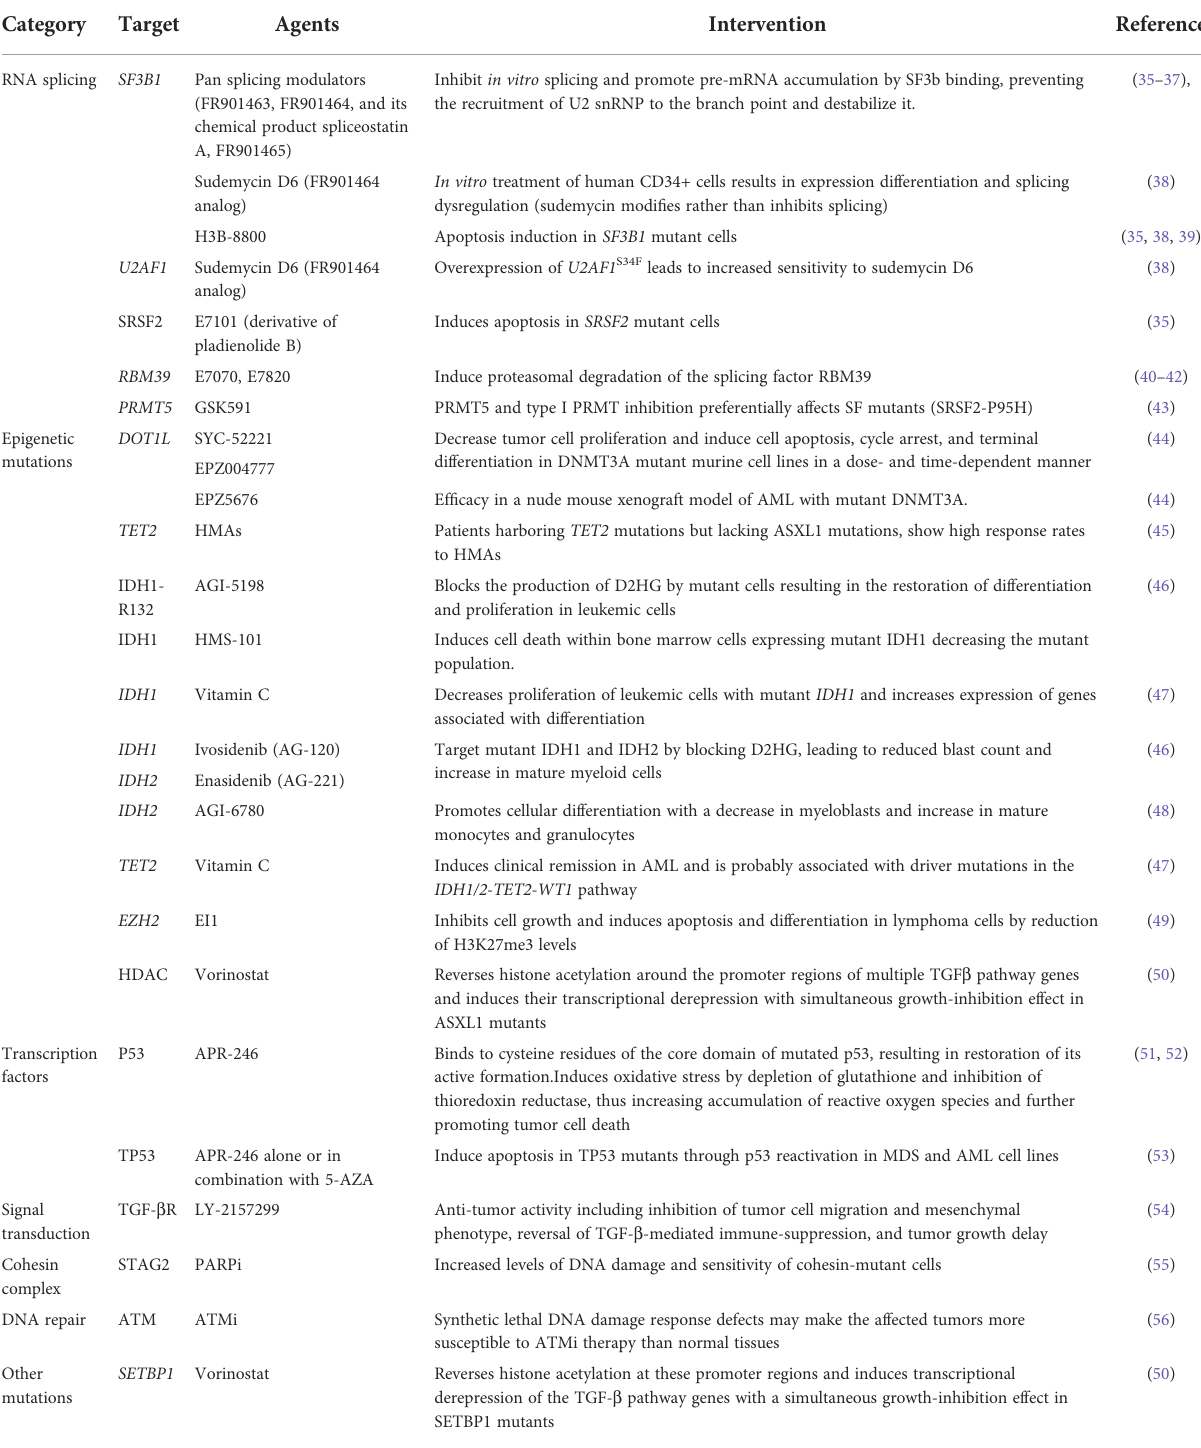
TABLE 2 Preclinical data on agents targeting mutations commonly found in patients with myelodysplastic syndrome.